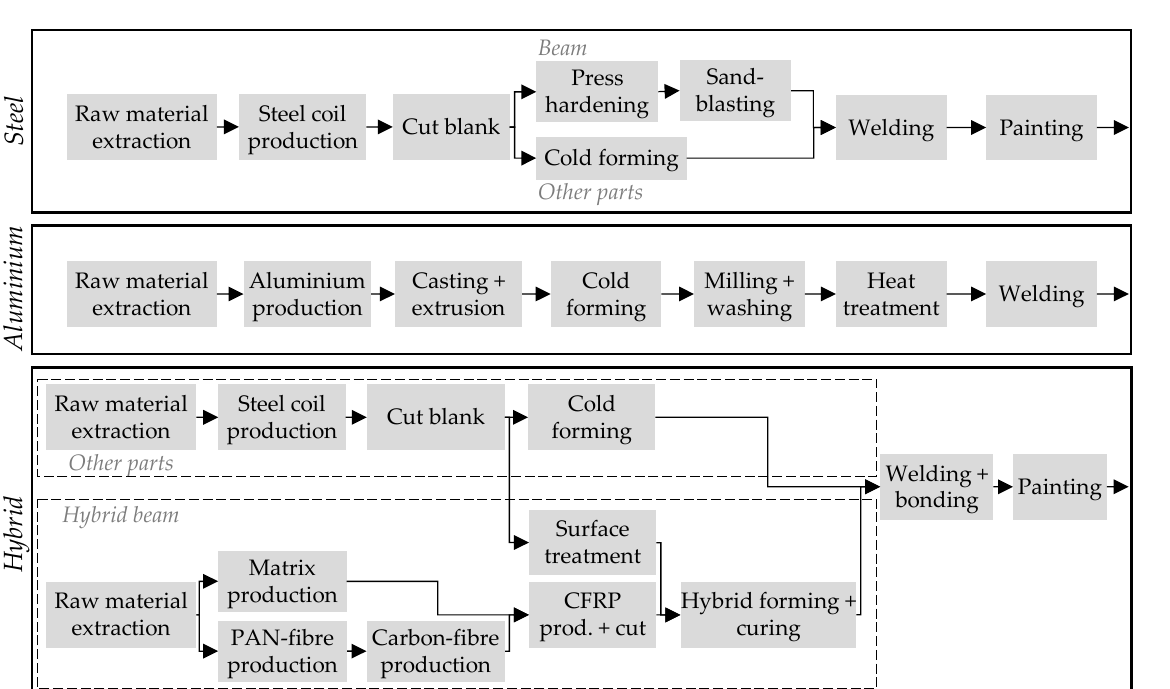
Reimer et al. [3,58] as well as Eberle and Franze [58] by multiplying the CMS masses in kg ( m CMS ) and the ERV of 0.44 kWh/(100 km × 100 kg) [59] by the reciprocal of the charging efficiency ( η charge ) of 90%. The chosen ERV does not consider secondary mass effects and represents a midclass BEV and the Worldwide harmonised Light vehicles Test Procedure (WLTP) driving cycle.